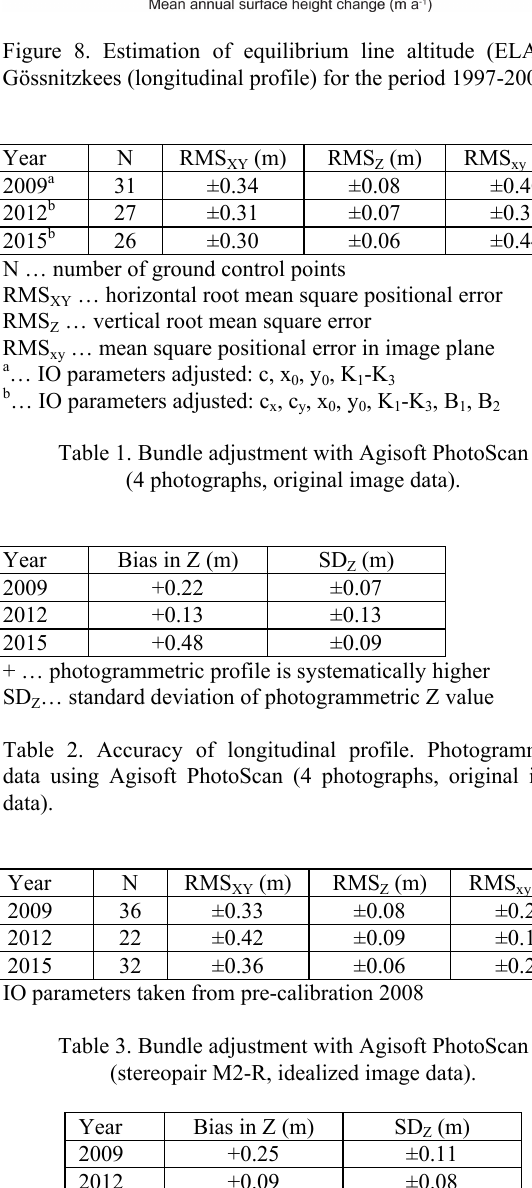
Table 4. Accuracy of longitudinal profile. Photogrammetric data using Agisoft PhotoScan (stereopair M2-R, idealized image data).